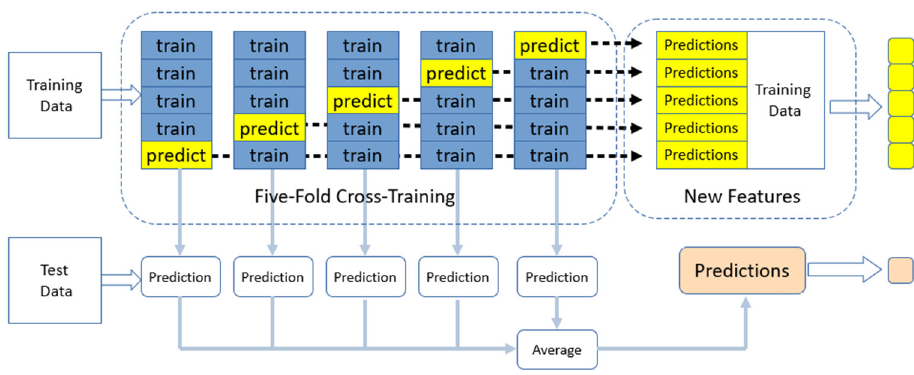
Figure 4. Five-fold cross-training process [23].